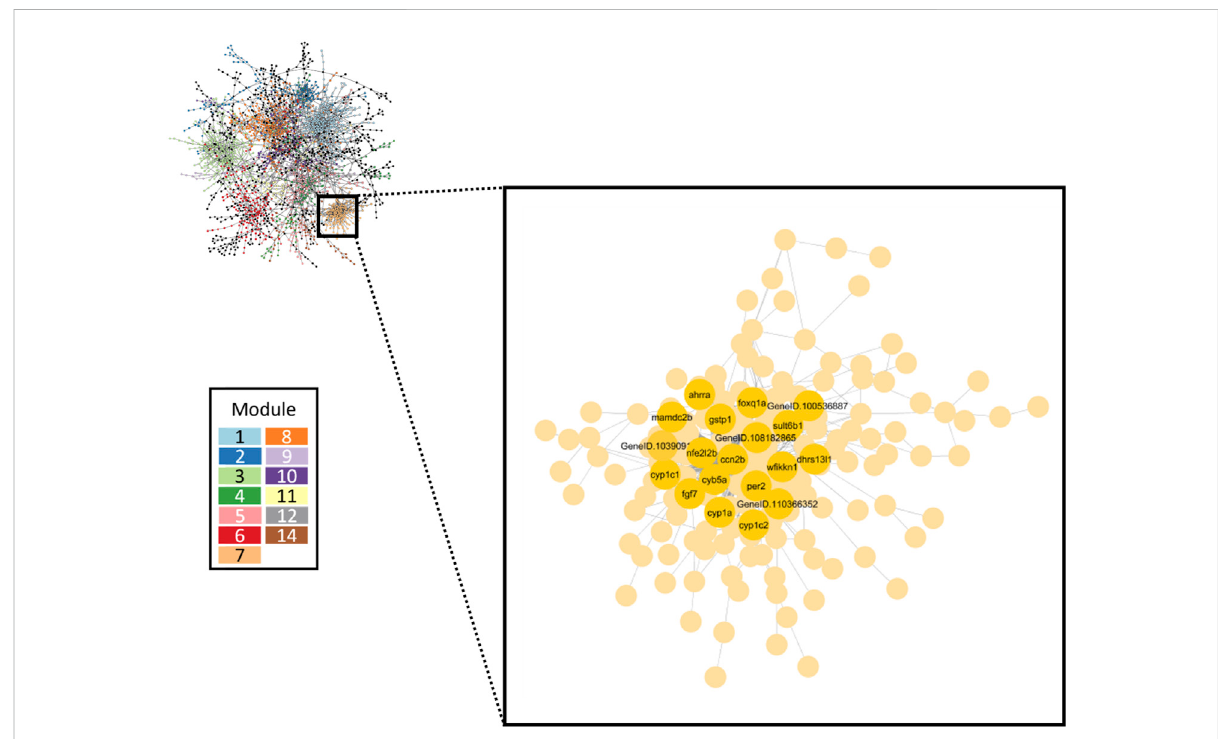
FIGURE 7 Gene co-expression network inferred from all retene concentrations. The largest 13 modules are differentiated by color. The inset box highlightsModulesevenwhichcontainedthegreatestnumberofhighrespondinggenes.Blackandgreenclustergeneswhichshowedthestrongest change in expression in response to increasing retene concentration are denoted.